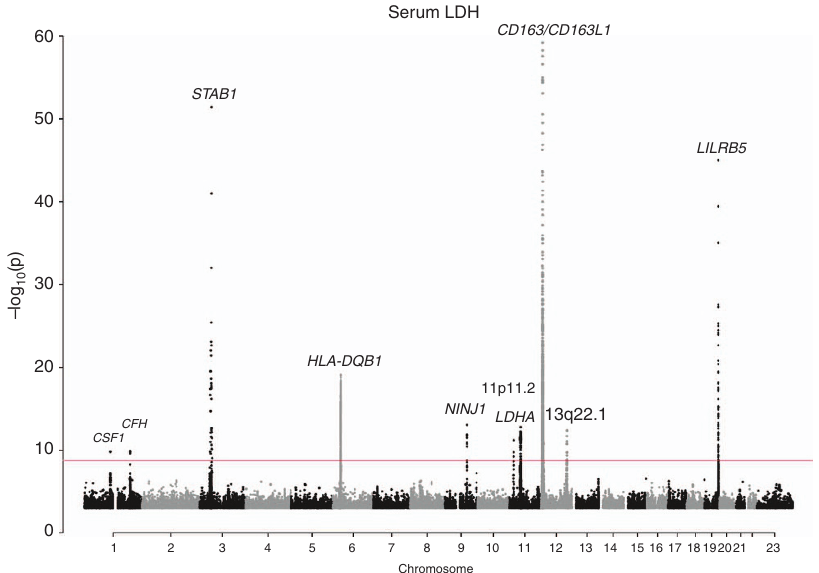
Figure 2 | Manhattan plot showing the 10 loci harbouring genome-wide significant signals influencing serum LDH levels in the Icelandic population. Variants are plotted by chromosomal position ( x axis) and (cid:3) log 10 P values ( y axis). P values above 1 (cid:2) 10 (cid:3) 60 are represented. One locus ( CD163L1 ) harbours a variant with P value below this cutoff (rs4072797: P ¼ 9.9 (cid:2) 10 (cid:3) 89 ). The red line indicates the threshold for genome-wide significance, determined by the number of tests performed ( P ¼ 0.05/28.3 million ¼ 1.8 (cid:2) 10 (cid:3) 9 ).